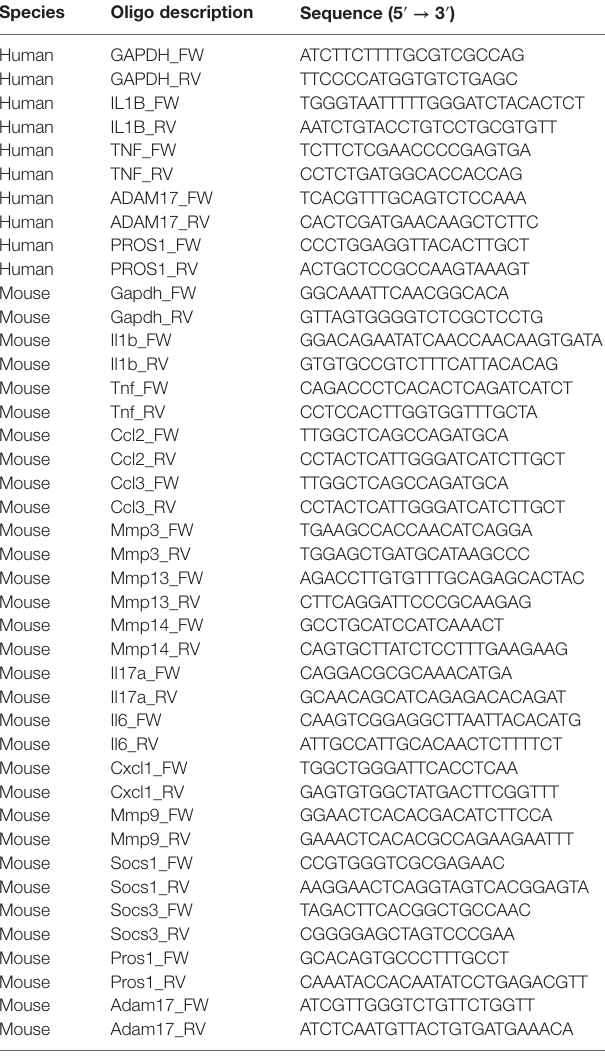
Table 2 | List of oligonucleotide primer sequences. species Oligo description sequence (5 ′ → 3 ′